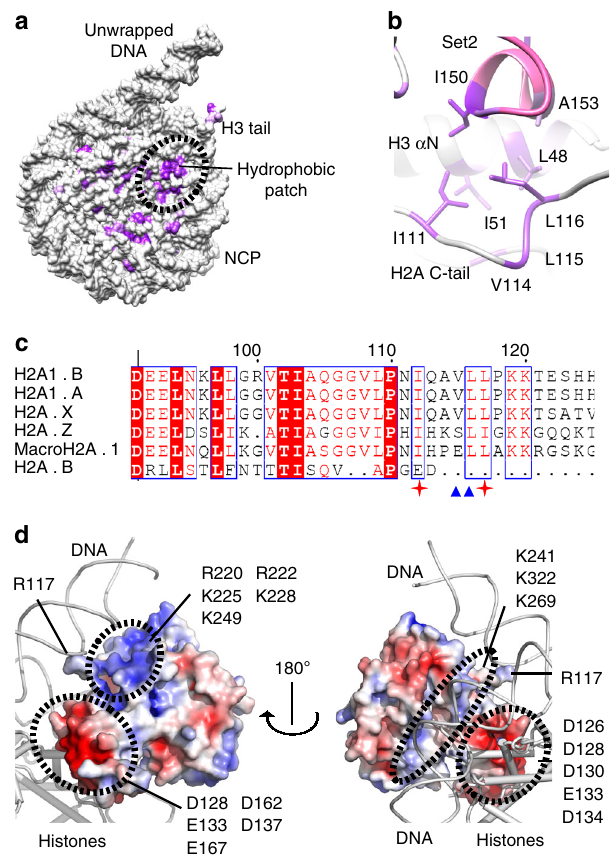
Fig. 3 Set2 makes hydrophobic and charged interactions with NCP. a Hydrophobic residues on the surface of NCP are shown in violet. Black dashed circle marks hydrophobic patch on the NCP. b Hydrophobic patch of NCP is formed by H3 α N residues I51 and L48 and H2A C-terminal tail residues I111, L115, and L116. Set2 residues I150 and A153 bind the hydrophobic patch of NCP. c Sequence alignment of the C-terminal tail of the representative H2A histone variants. Conserved residues are highlighted in red. The position of I111 and L116, residues that build hydrophobic pocket on the nucleosomal surface, are labeled with the red cross. V114 and L115 that position H2A C-terminal tail are marked with blue triangle. Residues important for the interactions with Set2 enzyme are not conserved in H2A.B. The alignment was generated with the ESPript server (http://espript.ibcp.fr) 83 . d Electrostatic surface potential of Set2. Set2 surface facing DNA is predominately positively charged (blue), whereas Set2 residues facing positively charged histones are mainly negatively charged